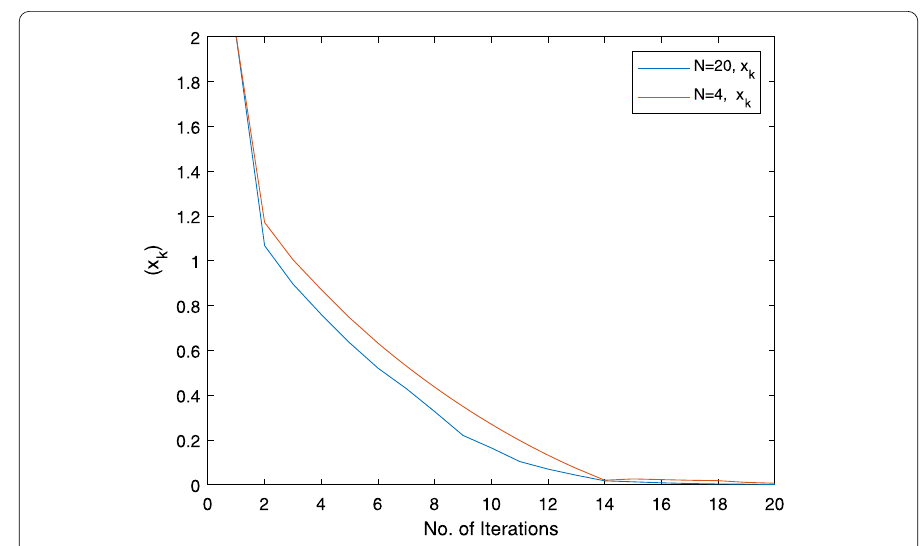
Figure 3 Comparison between trajectories of Algorithm 2 for Choice 1 with N = 20 and N = 4